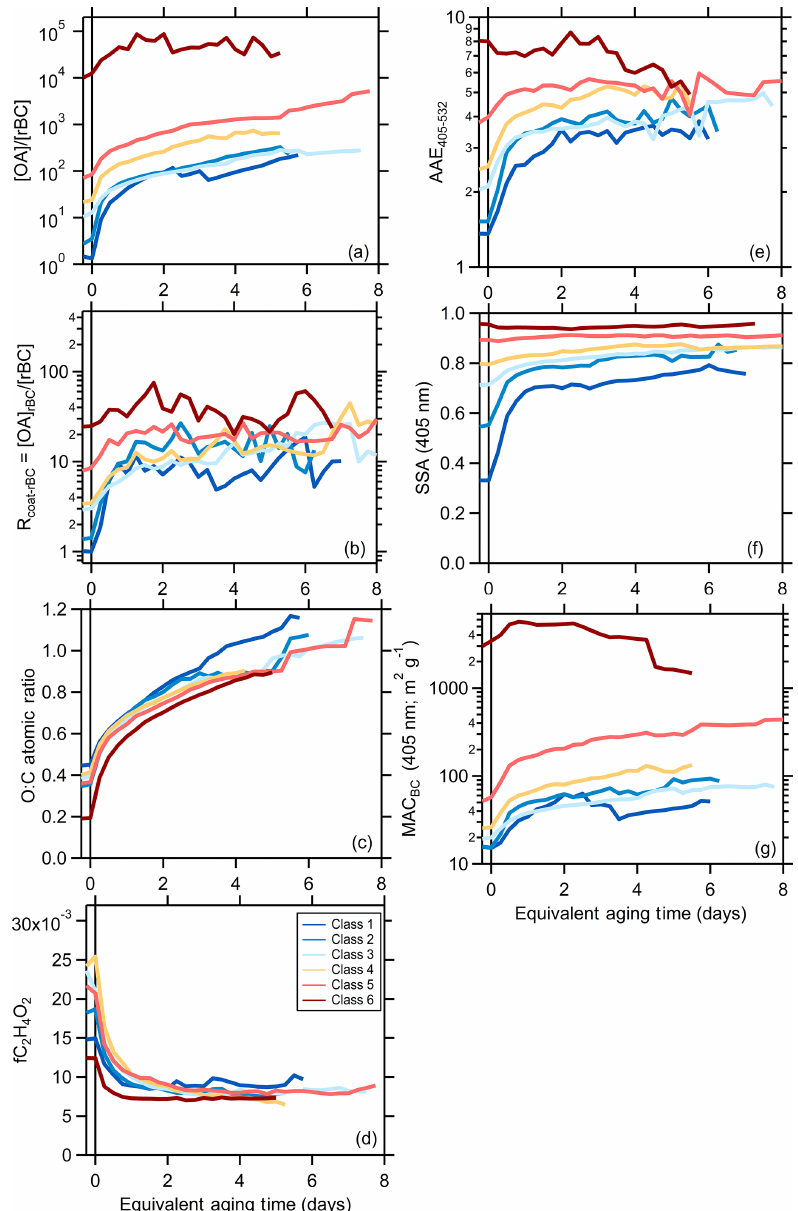
Figure 1. Relationship between (a) the [ OA ] / [ rBC ] ratio, (b) R coat-rBC , (c) AAE 405–532 , (d) the SSA at 405nm, (e) the O:C atomic ratio, (f) the AMS f 60 , and (g) the MAC BC at 405nm as a function of equivalent photochemical aging time (assuming [OH] = 1 . 5 × 10 6 moleculescm − 3 ). The different lines are colored according to the SSA classification and are averages for all burns within a class (see panel d ). Figures showing results for each burn are available in the Supplement. Some of the apparent discontinuities for individual classes with certain properties results from a change in the number of individual experiments contributing to the average above a given aging time.